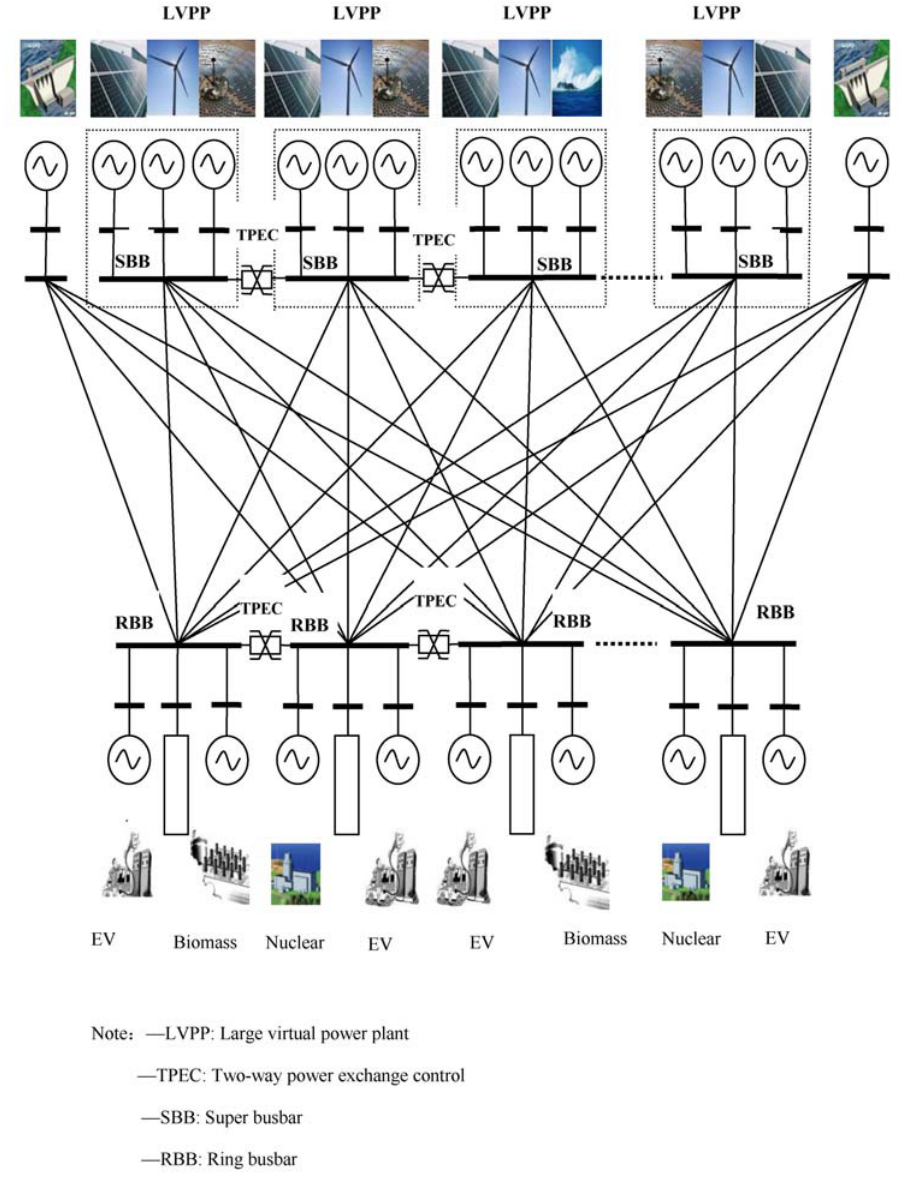
Figure 1. Basic structure of the transmission network in the